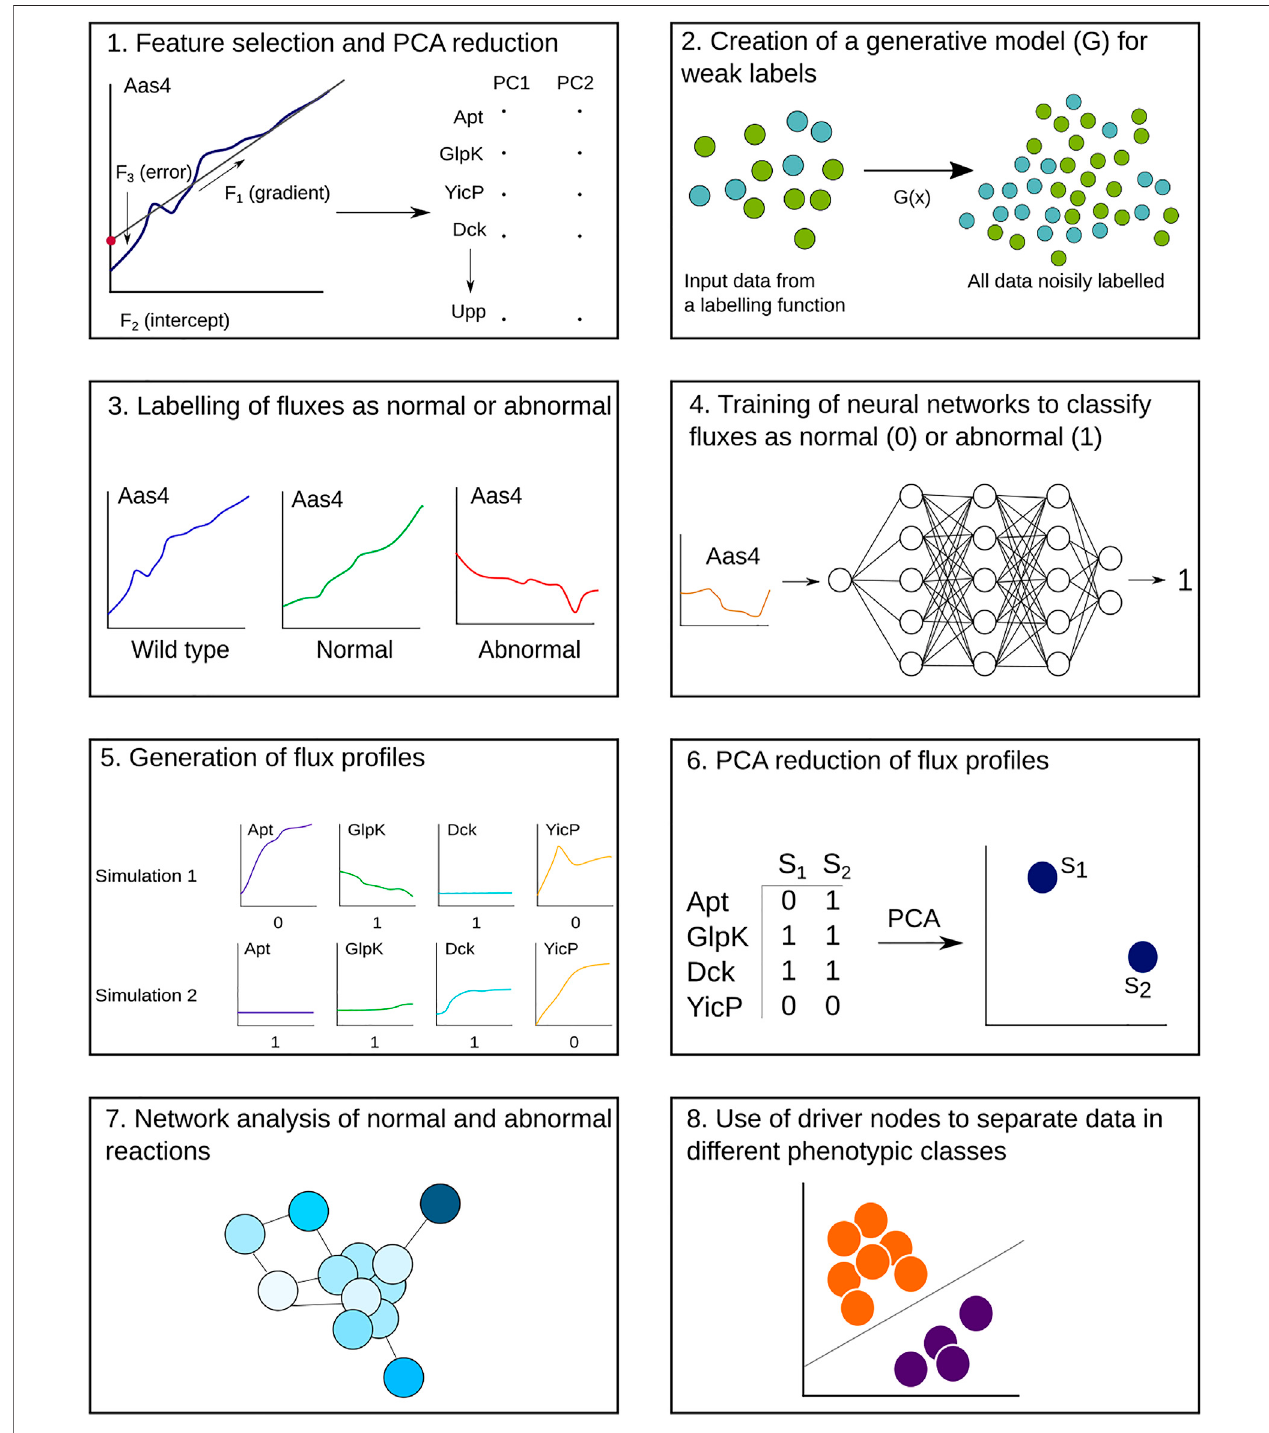
FIGURE 1 | Step-by-step work fl ow of the analysis pipeline, beginning with the metabolic fl uxes from the whole-cell model output. Steps 1 – 4 are applied to a training dataset of gene knockout simulations, where the end result is a trained neural network for each reaction. (1) For each reaction fl ux time series, four features are extracted and reduced to two dimensions through principal component analysis (PCA). (2, 3) The extrema of these data are used to de fi ne boundaries for normal and abnormalbehaviours,whicharethenusedtocreateagenerativefunctiontomaplabelsontothereactions.(4)Neuralnetworksaretrainedusingtheselabelleddata to classify reactions as normal or abnormal. Steps 5 – 8 are applied to a separate analysis dataset of gene knockout simulations. (5) The neural networks are used to classify the analysis dataset and create a fl ux pro fi le for each simulation. (6) The fl ux pro fi les are reduced to two dimensions and plotted. (7, 8) Network analysis of the reactions reveals nodes that control the metabolic network and correlate with different phenotypes after gene knockouts.